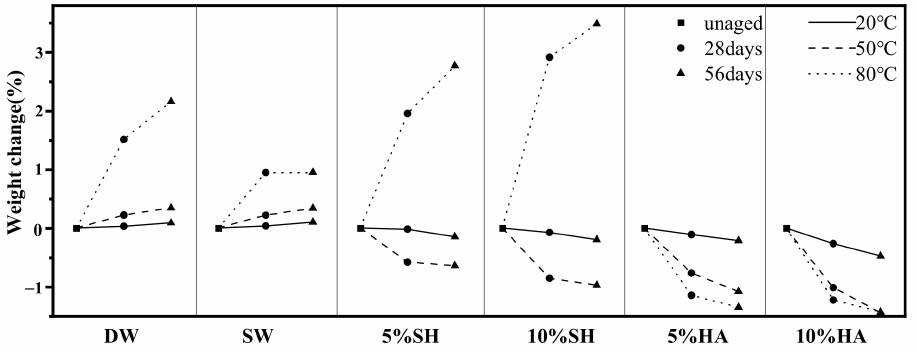
Figure 6. Change in specimen mass under various